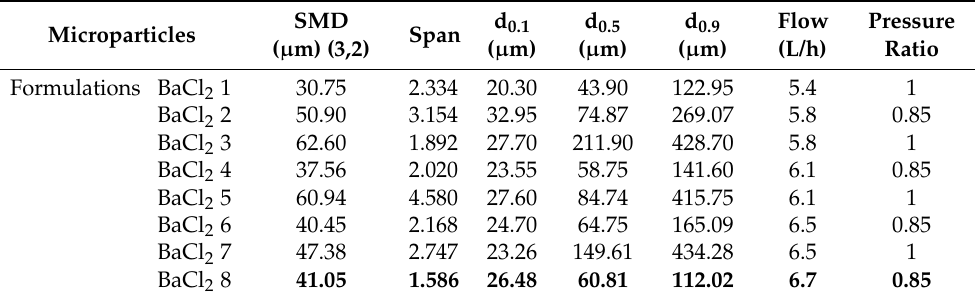
Table 5. Particle size of alginate particles with barium chloride as crosslinker.